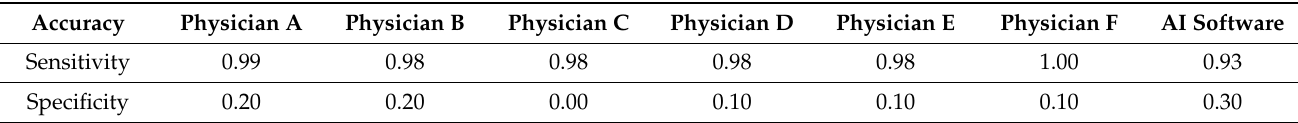
Table 2. Sensitivity and specificity of physicians and the AI